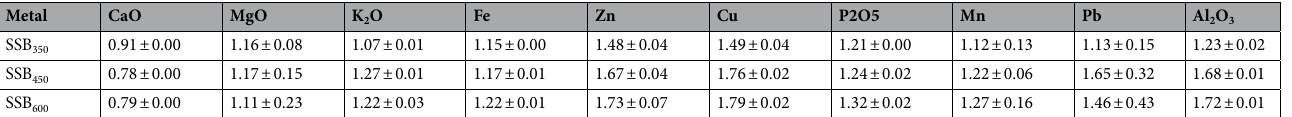
Table 4. Metal enrichment Index of the biochar produced at 350 (SSB 350 ), 450 (SSB 450 ) and 600 (SSB 600 ) as compared to the feedstock.